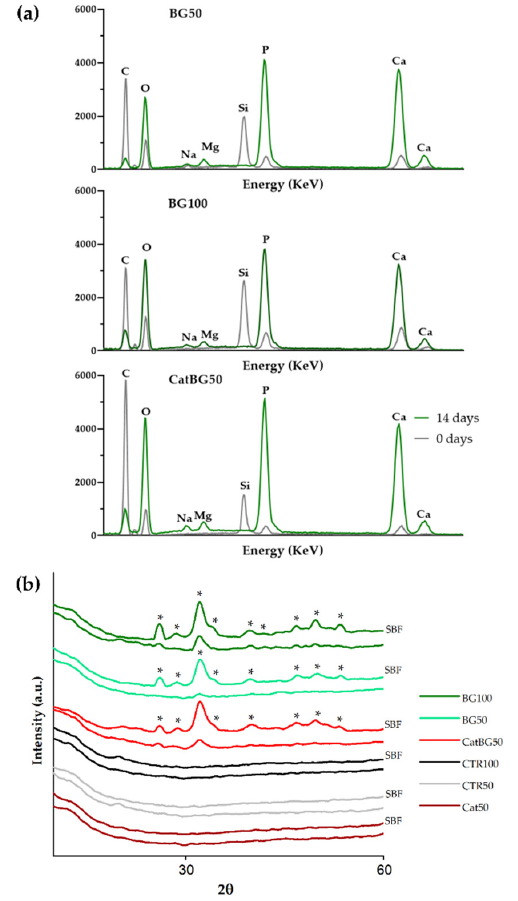
Figure 14. In vitro bioactivity study of the LbL films after immersion in SBF for 14 days: ( a ) EDS and ( b ) XRD spectra. Hydroxyapatite peaks are indicated ( * ).